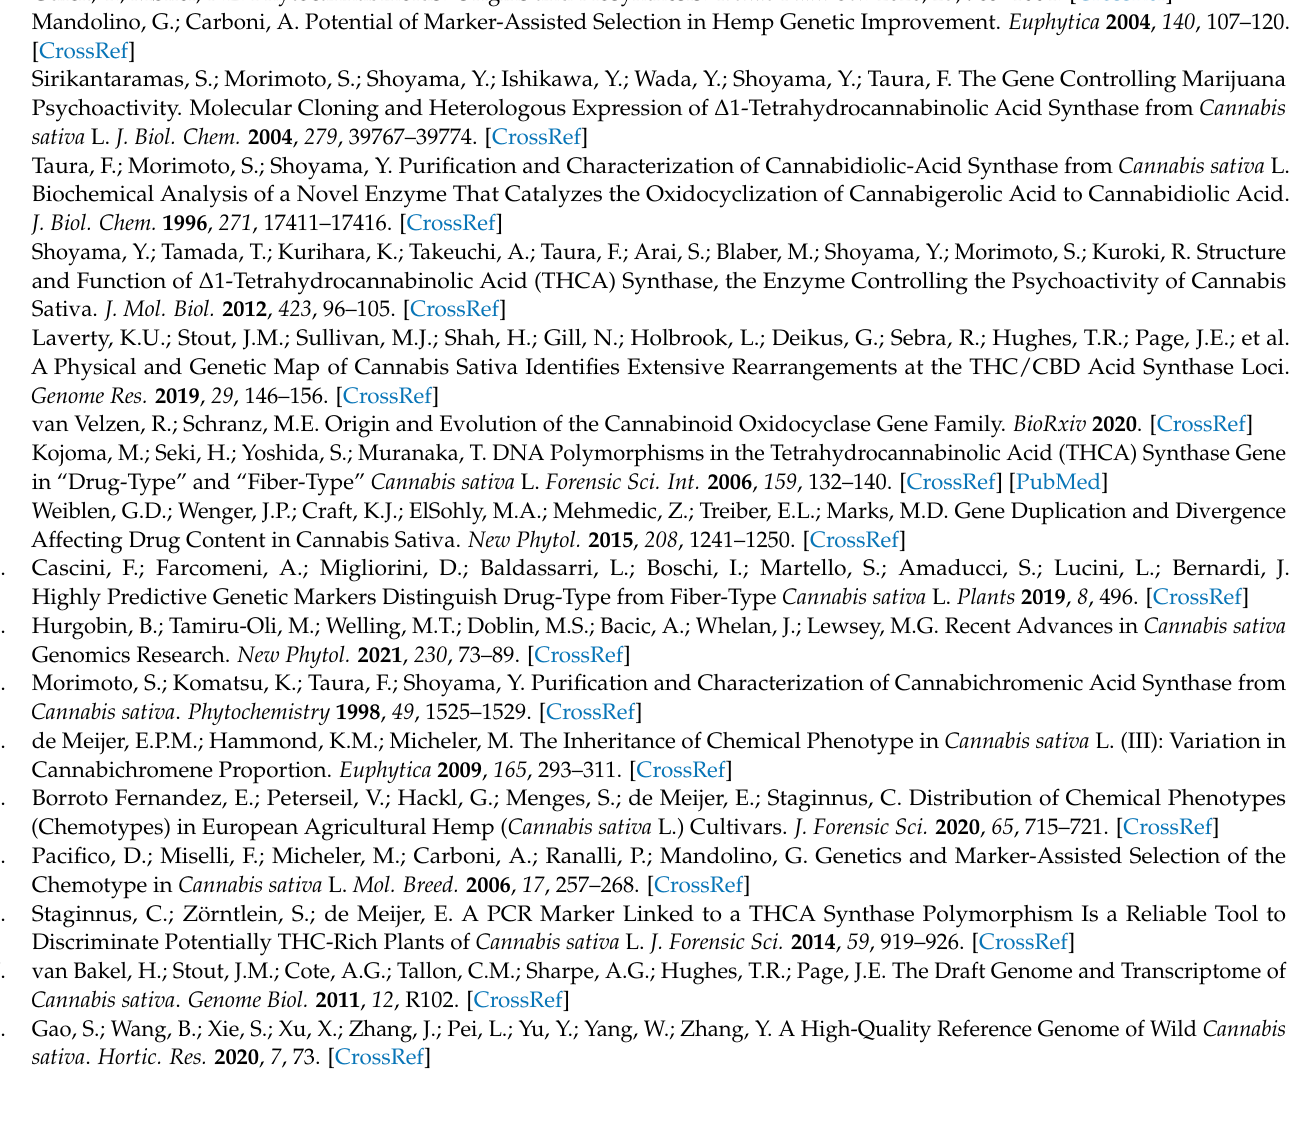
Figure A8. Melting curve plots, which display data collected during a melting curve stage with primers CBCAS_F and CBCAS_R. Peaks in the melting curve may indicate the melting temperature (Tm) of a target or identify nonspecific PCR amplification. No peaks were seen for the no template control (H 2 O) and for negative controls ( THCAS plasmid, CBDAS plasmid).